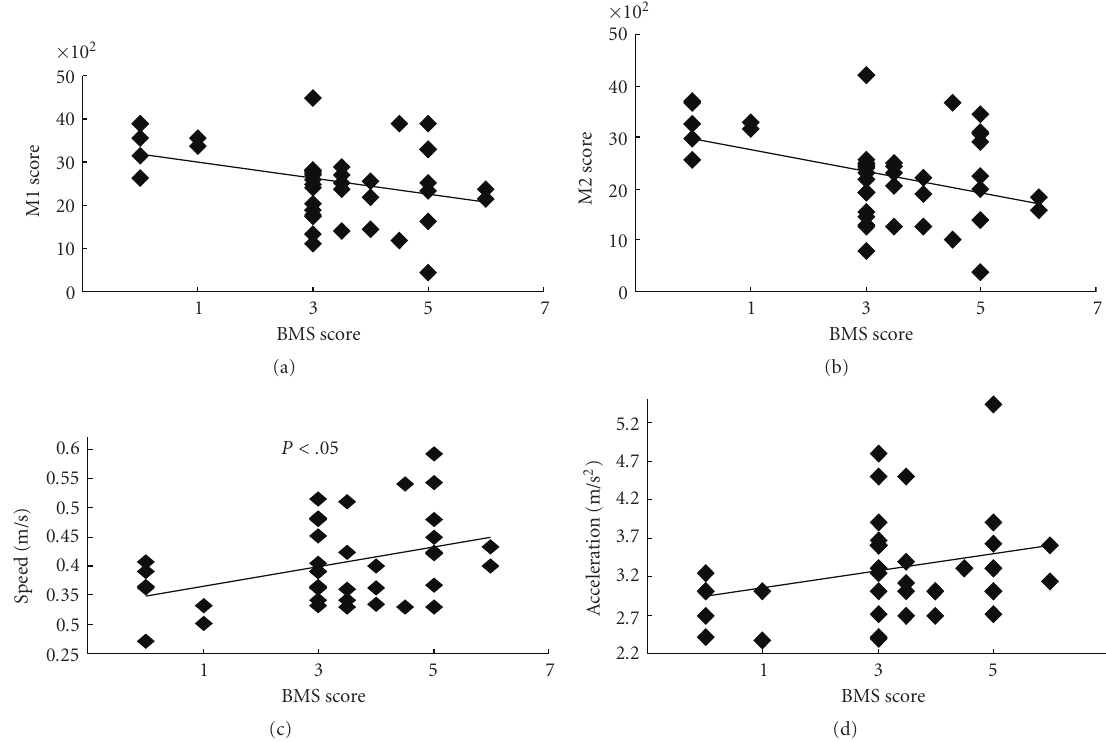
Figure 4: Correlation diagrams of parameters. M1 and M2 scores had minus correlations with the BMS score, while the speed and acceleration showed a strong correlation. Coe ffi cients of correlation are − 0.84 for M1 and BMS, − 0.83 for M2 and BMS, 0.75 for speed and BMS, and 0.77 for acceleration and BMS.